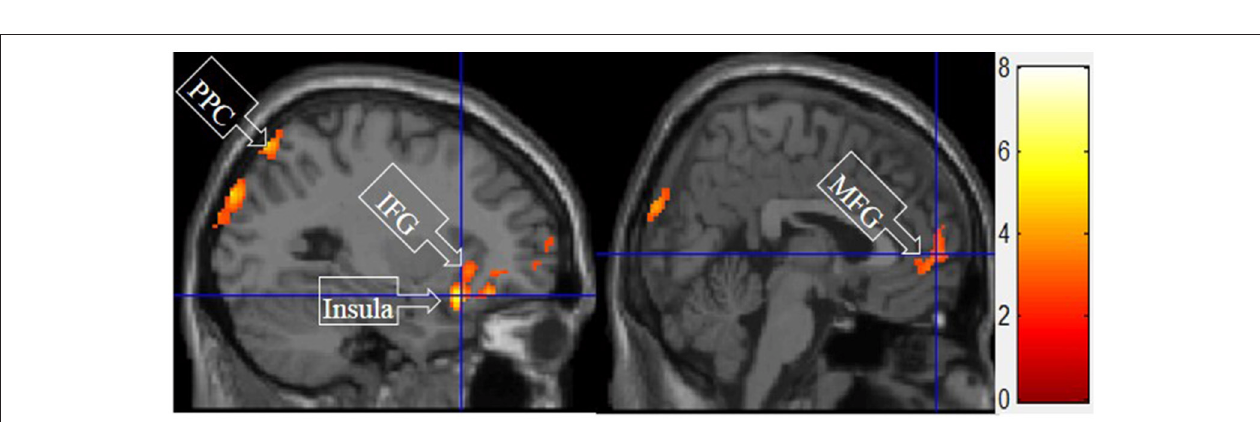
FIGURE 6 | Experiential motivation > symbolic and functional motivations. The color bar reflects t -values that resulted from the contrast. The PPC, parahippocampal gyrus, and amygdala showed significantly higher activation while processing products with experiential motivation as compared to both symbolic and functional motivations.